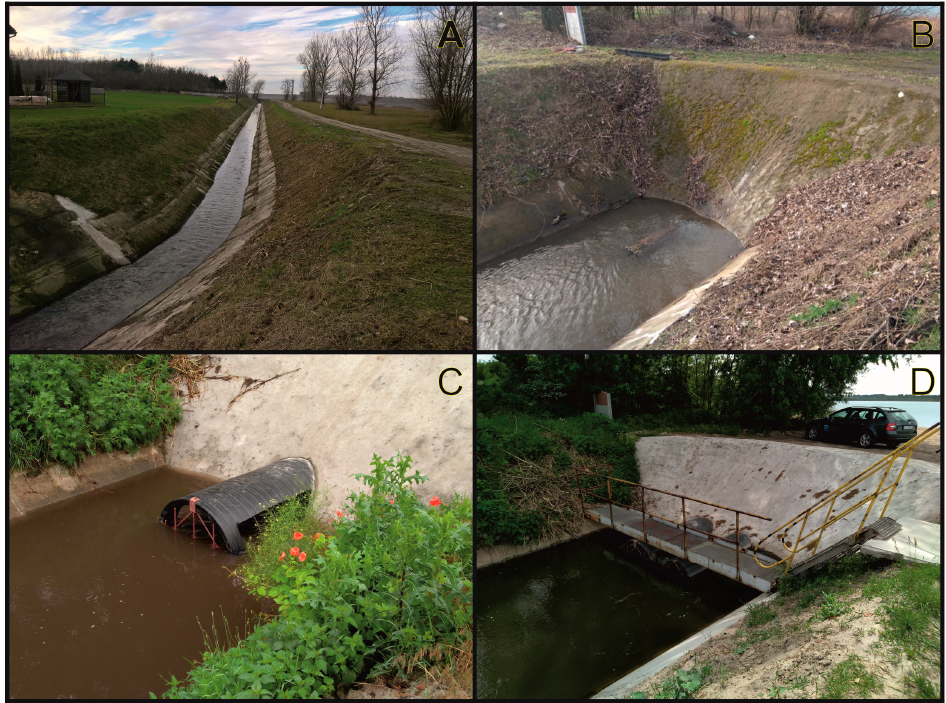
Figure 5. System supplying the post ‐ mining reservoir Kleczew with mine waters from drainage of the opencast mine Jó ź win IIB: ( A )—ditch supplying water, ( B )—pipe supplying water in the period VII.2016 ‐ VI.2020 ( Φ = 500 mm), ( C )—pipe supplying water in the period VI.2020 ‐ XII.2020 ( Φ = 1000 Φ = 500 mm), ( C )—pipe supplying water in the period VI.2020-XII.2020 mm), ( D )—pipes supplying water since XII.2020 (2 × Φ = 1000 mm). period VII.2016-VI.2020 ( ( Φ = 1000 mm), ( D )—pipes supplying water since XII.2020 (2 × Φ = 1000